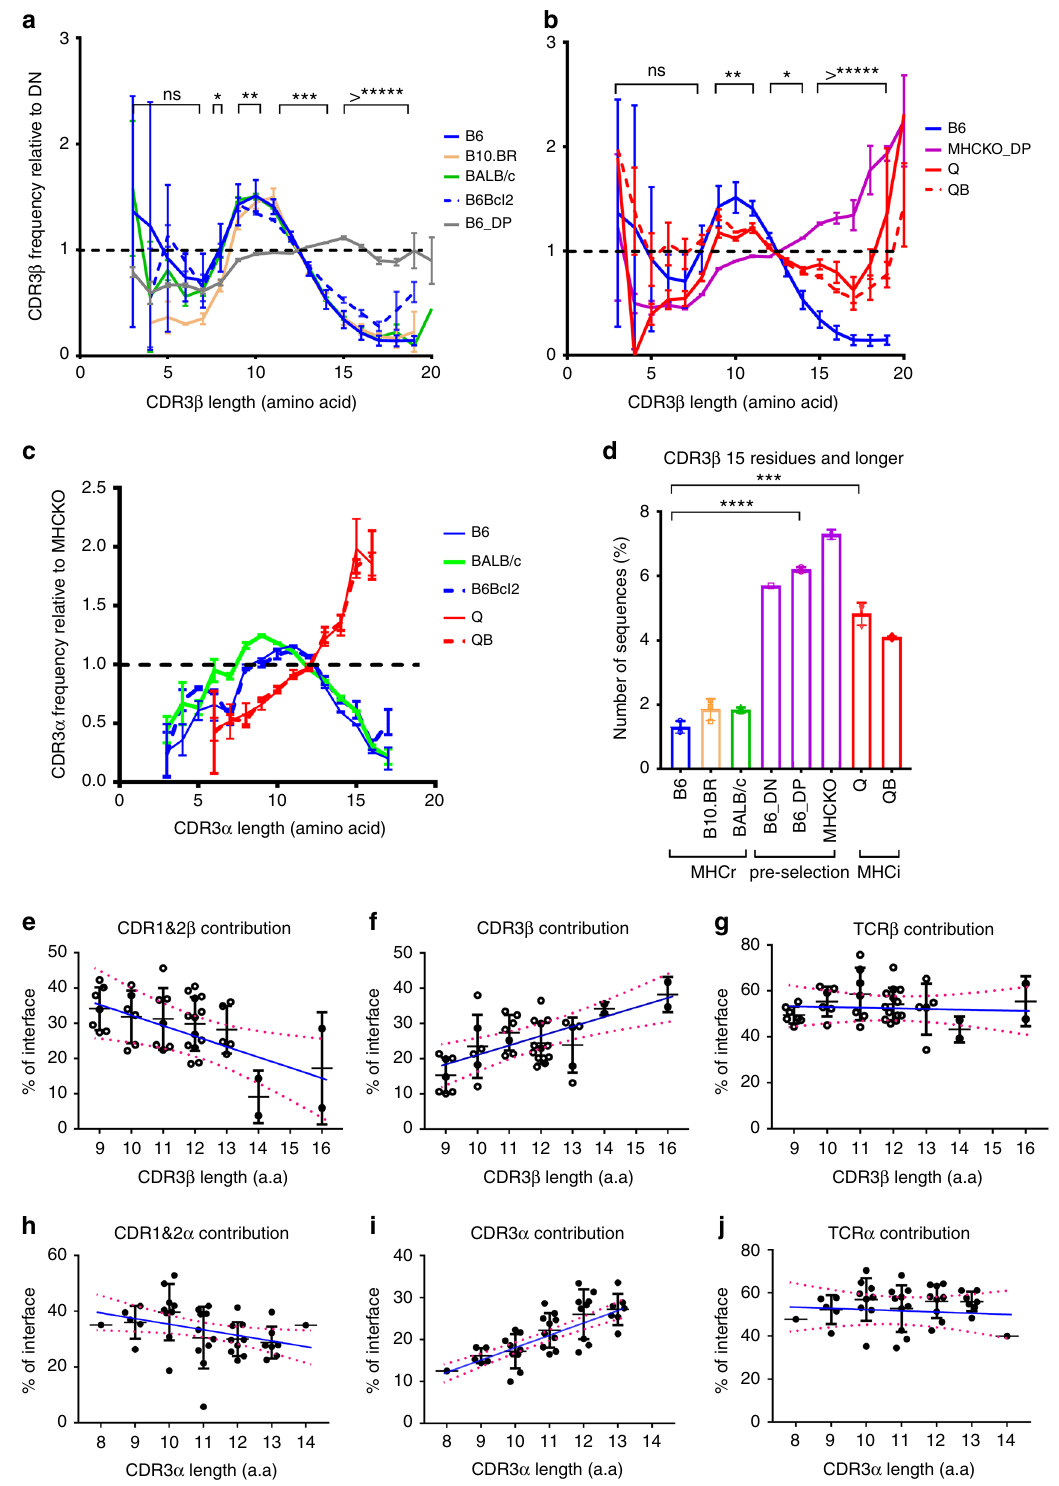
Fig. 4 Normalized CDR3 length distributions. a – c Comparisons of normalized CDR3 length distributions of TCR β ( a – b ) and TCR α ( c ) among MHCr, MHCi and pre-selection repertoires. The repertoire-speci fi c preference of CDR3 length distributions is indicated by respective fold changes when normalized to B6 DN for TCR β ( a, b ) or the average of MHCKO DP for TCR α ( c ) sequences. Unless otherwise noted, the CDR3 length and all other analyses reported here were carried out using all repertoire data listed in Supplementary Tables 1 & 2 without rejection and regardless of the sequencing depth variation. d MHCr repertoires contain fewer TCR β sequences with CDR3 length of 15 or longer than MHCi and pre-selection repertoires. e – j The MHC contact area from CDR3 and germline CDR1&2 displayed as percentage of total TCR-MHC interface area in each MHC-TCR complex structures from Protein Data Bank (PDB). Panels e – j are fi tted with linear regression using GraphPad Prism with dotted lines indicating 95% con fi